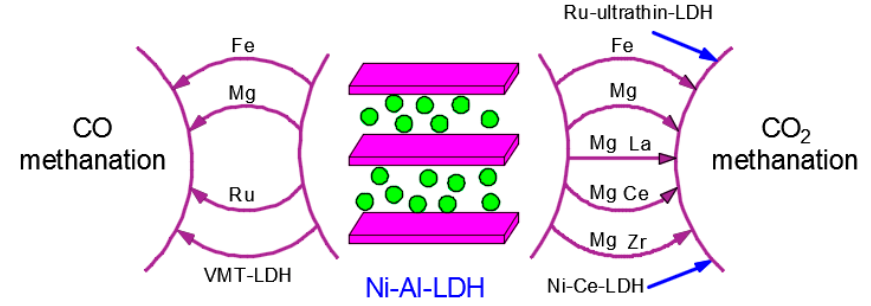
Figure 1. The applications of layered double hydroxides (LDHs) in CO and CO 2 methanation.